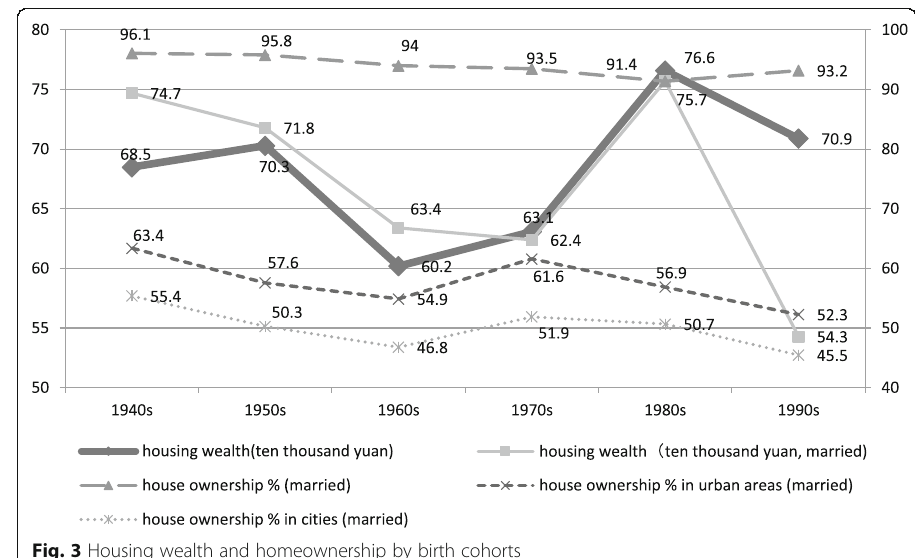
Fig. 3 Housing wealth and homeownership by birth